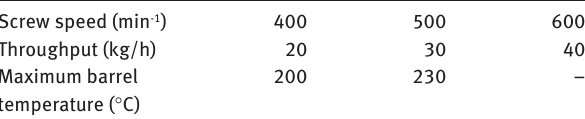
Table 2 Variation of the process parameters.